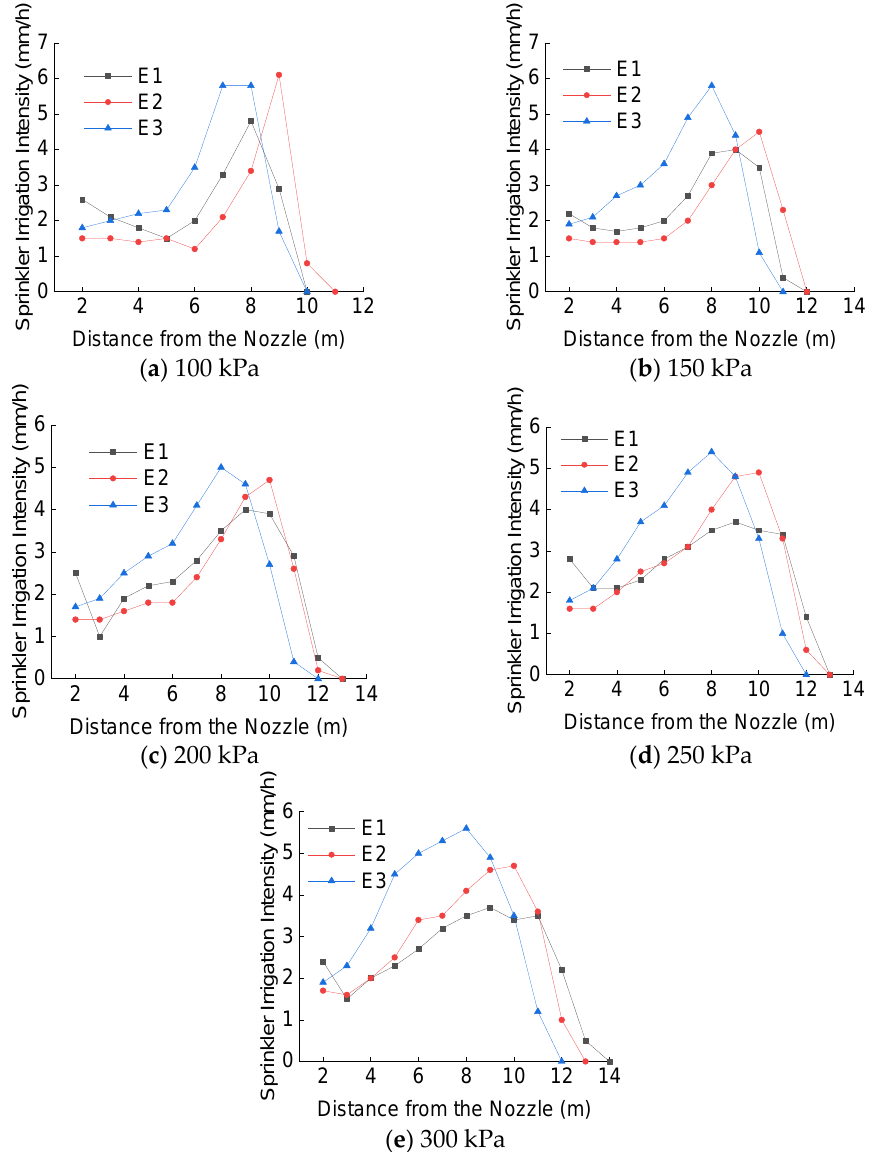
Figure 9. Radial water distribution of elliptical nozzles with different aspect ratios under different working pressure levels. (E1, E2, and E3 refer to the elliptic nozzles with aspect ratios of 1.43, 2, and 2.58, respectively).